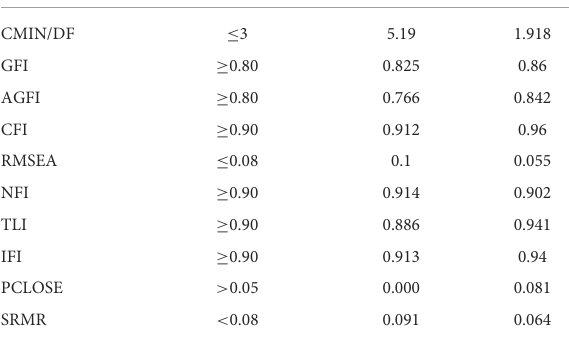
TABLE 4 Measurement model fitness